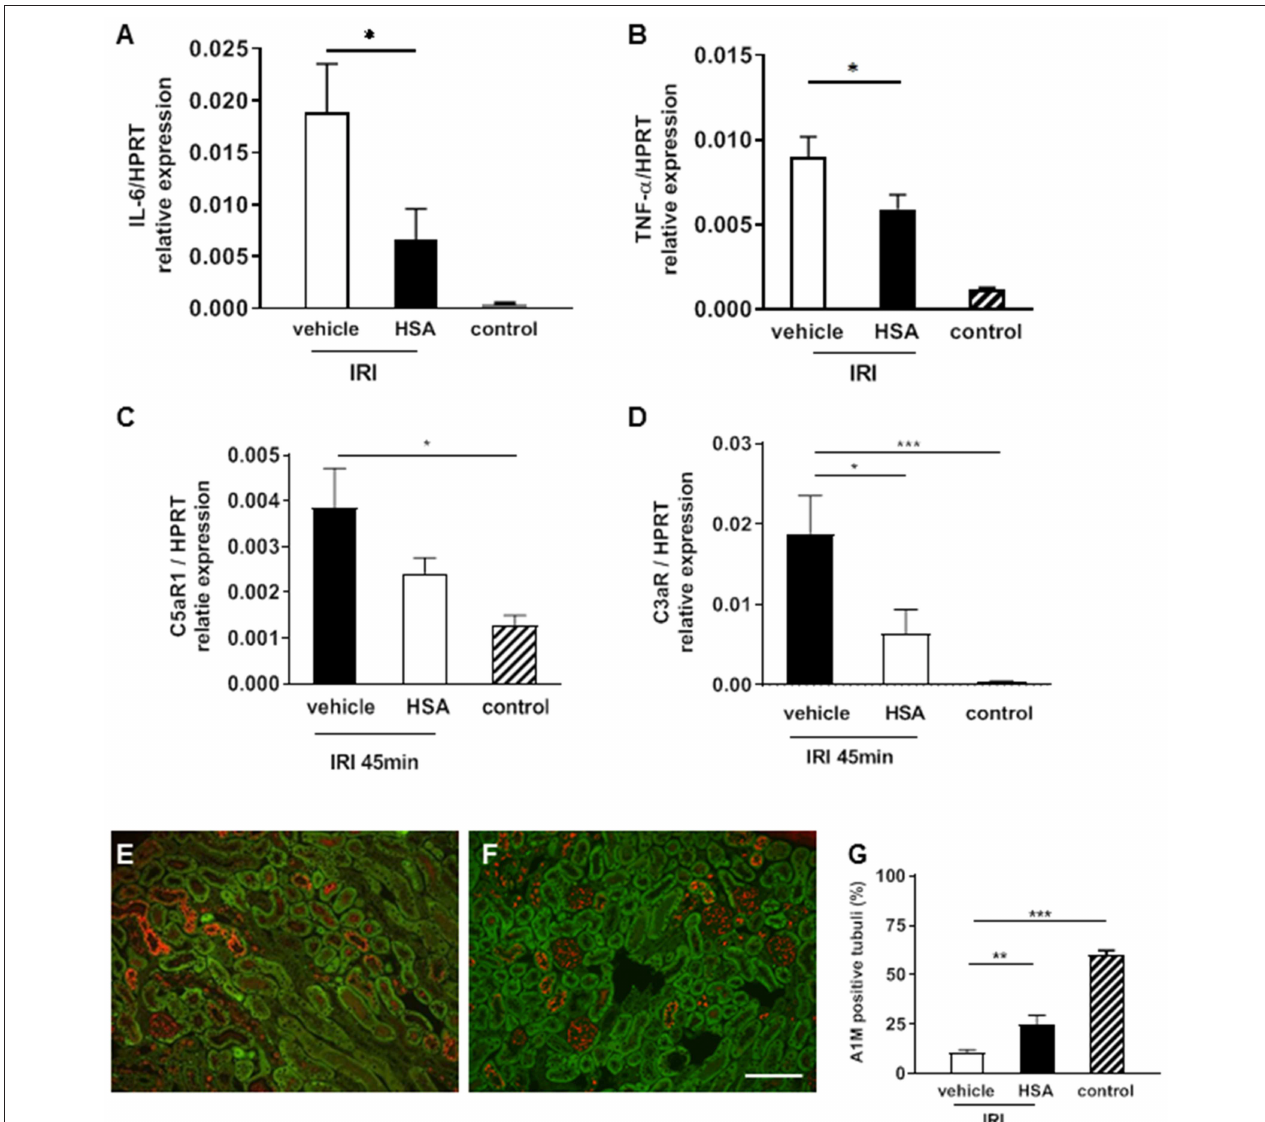
FIGURE 5 | Albumin treatment to attenuate IRI. Human serum albumin (HSA) was given intravenously 10min prior to IRI (45min). The pro-inflammatory cytokine IL-6 and TNF- α mRNA expression was significantly decreased in the albumin treatment group compared to the vehicle at 2h after IRI ( A,B * p < 0.05). C5aR1 expression was significantly higher in vehicle treated IRI kidneys compared to control kidneys ( C , * p < 0.05). C3aR mRNA expression was significantly reduced by albumin treatment compared to vehicle ( D , * p < 0.05). The tubular function marker A1M showed higher expression after albumin treatment in proximal tubular epithelial cells after IRI ( E–G , bar: 100 µ m mean ± SEM, * p < 0.05, ** p < 0.01, *** p < 0.001, n = 6 mice/group, one way ANOVA). n = 5 mice/group, one way